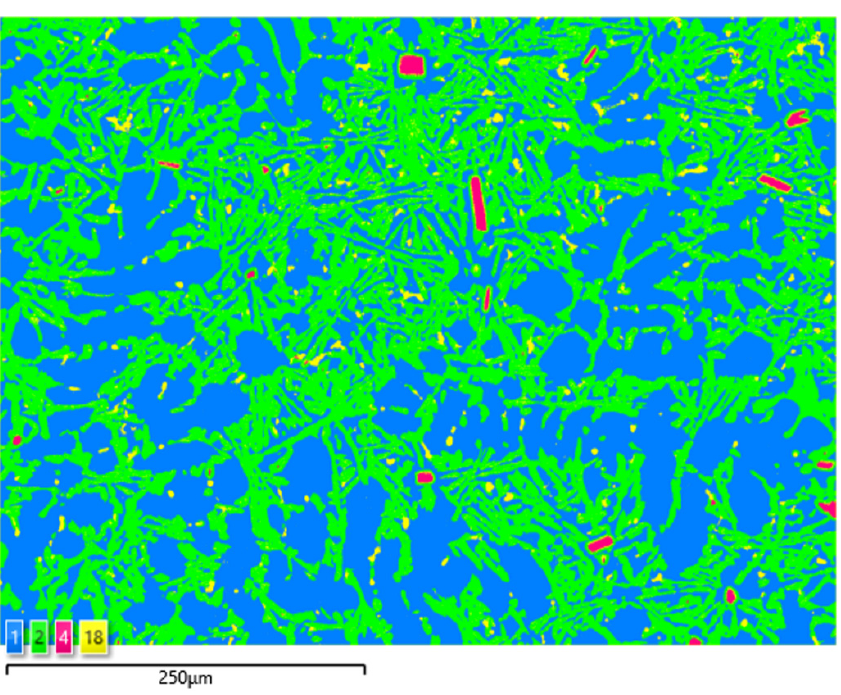
Figure 20. SEM-EDS image of AlSi10Sn1.7 alloy (1—Al; 2—AlSi; 4—SiAl; 18—AlSiSn). Table 9. Phases in AlSI10Sn1.7 alloy in micro area from Figure 20.